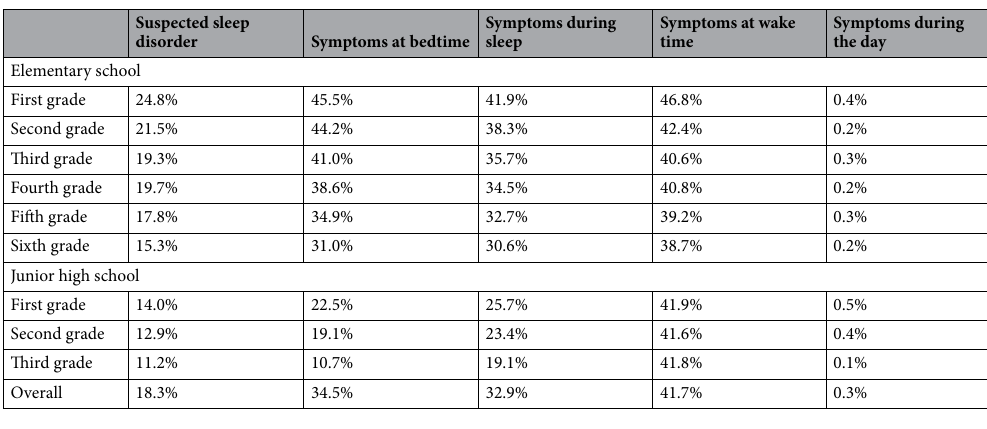
Table 2. Brief child sleep questionnaire by school grade.